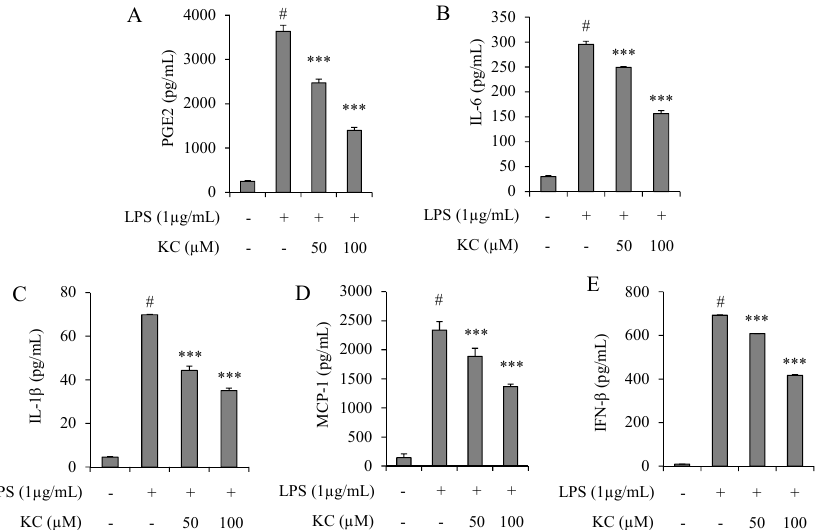
Figure 2. The effects of KC on PGE 2 ( A ), IL-6 ( B ), IL-1 β ( C ), MCP-1 ( D ), and IFN- β ( E ) production in LPS-stimulated RAW264.7 macrophages. RAW264.7 cells were pretreated with KC (50 or 100 µ M) and stimulated with LPS (1 µ g / mL). The culture media supernatants were collected and subjected to ELISA. Error bars represent the means ± SDs, # p < 0.001 vs. control, *** p < 0.001 vs. LPS-only treated cells.